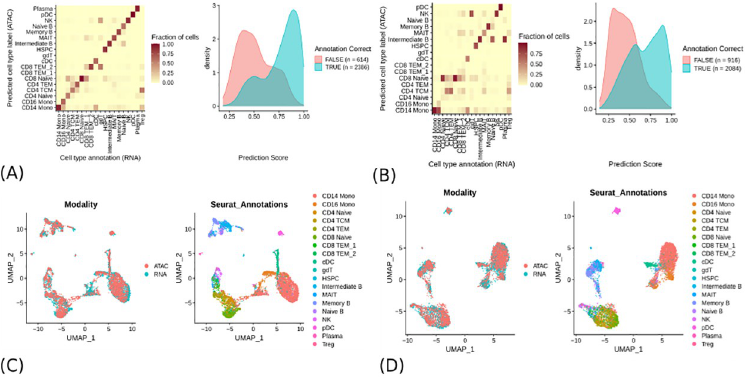
Fig 5. Cell label transfer from expression to accessibility data for raw 5A and SCRaPL 5B preprocessed data. Visualization of sc-RNA and scATAC data on the same plot for raw 5C and SCRaPL 5D preprocessed data.